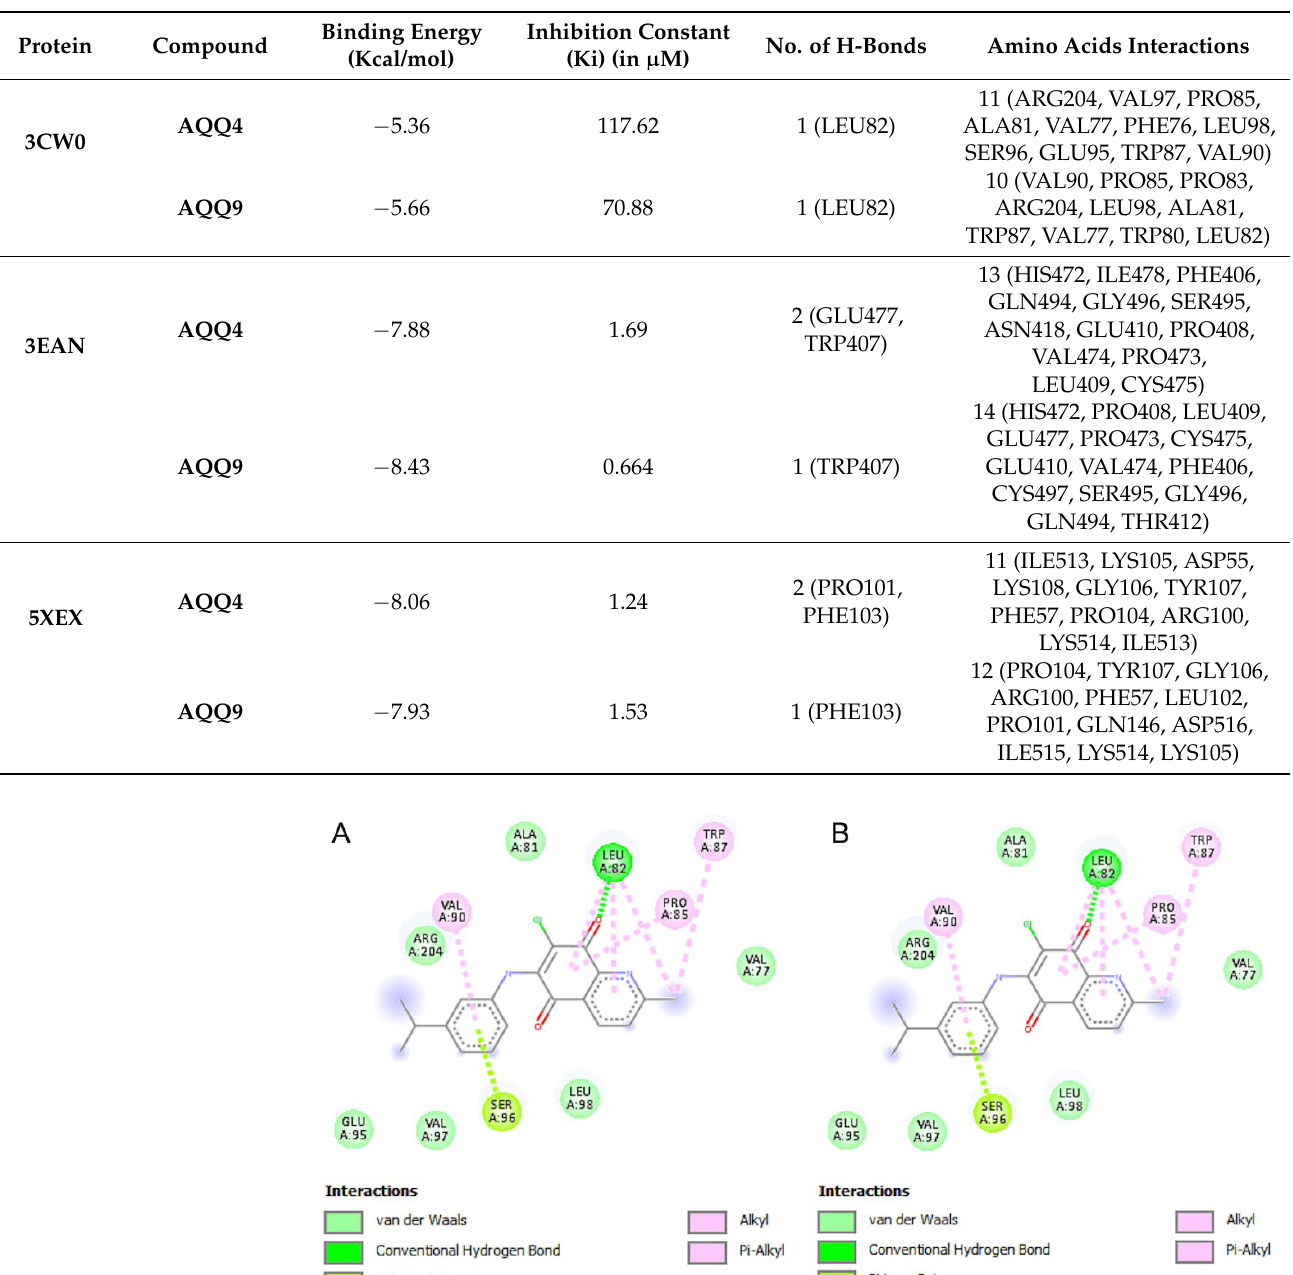
Table 4. A summary of molecular docking studies for AQQ4 and AQQ9 against the three protein targets.